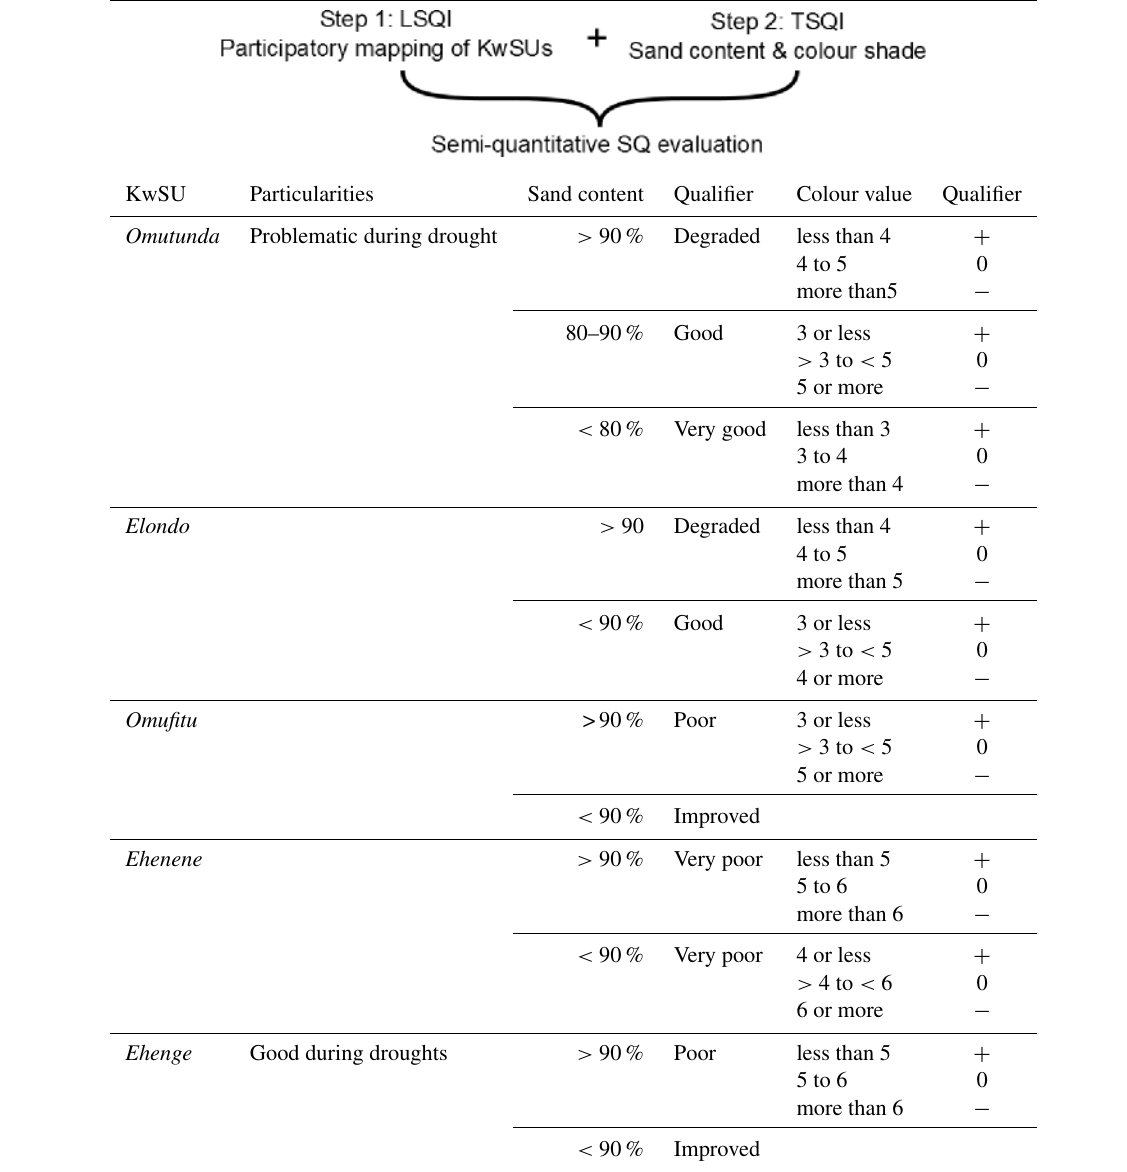
Table 10. Schematic representation of the suggested SQ toolbox. It integrates Local Soil Quality Indicators (LSQI) and Technical Soil Quality Indicators (TSQI) to create a semi-quantitative evaluation. Hierarchical SQ evaluation. The evaluation starts with LSQI and classifies location into Oshikwanyama Soil Units (KwSU), afterwards technical assessment is used to determine, chemical fertility potential (sand) and the soil organic carbon (SOC) status